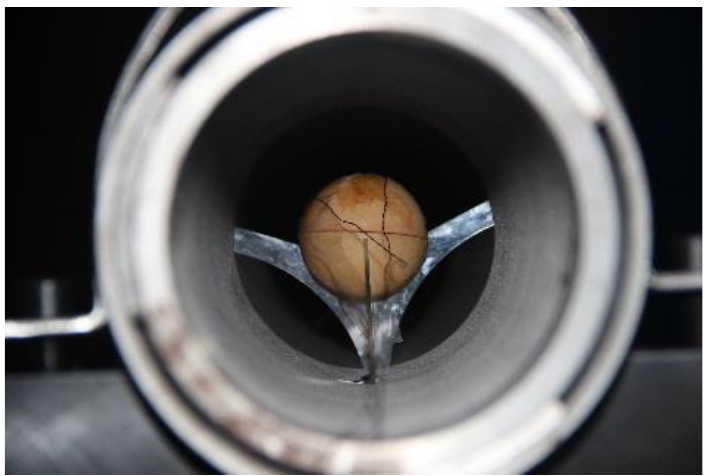
Figure 3. Installation of spherical charge in the double-layer cylindrical shells.